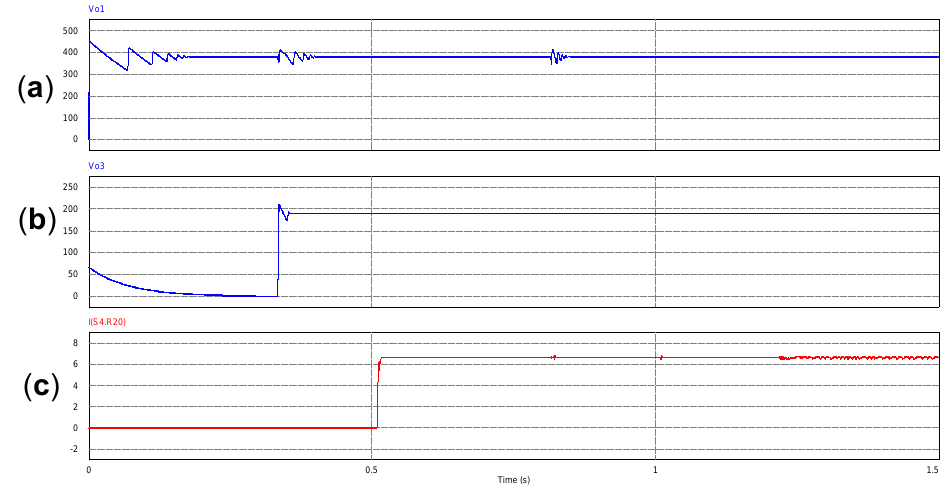
Figure 28. Waveforms are: in Figure 28a, principal bus voltage and Figure 28b, 1.2 kW converter output voltage are used like time references; Figure 28c shows current